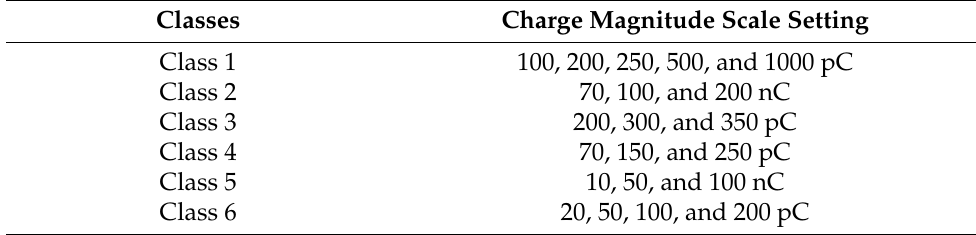
Table 1. Different levels of charge magnitude scale setting on the Omicron